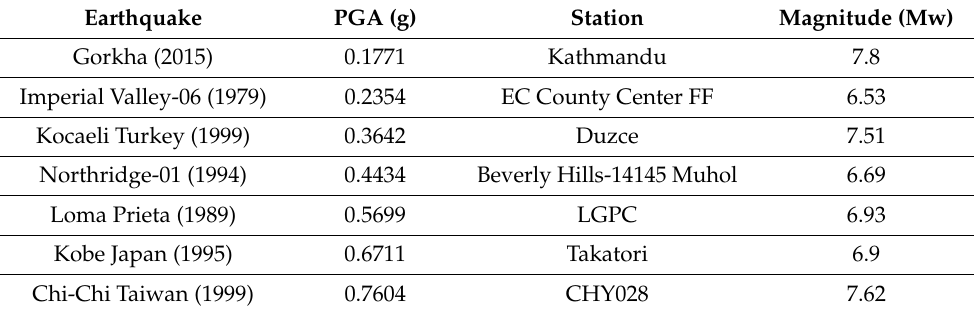
Table 3. Acceleration time histories used for analysis.